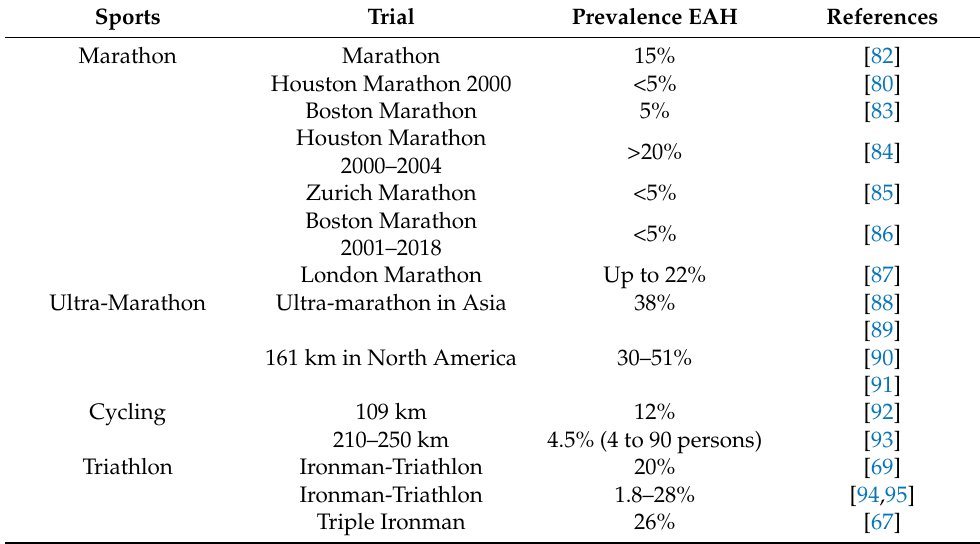
Table 3. Prevalence of exercise-associated hyponatremia.